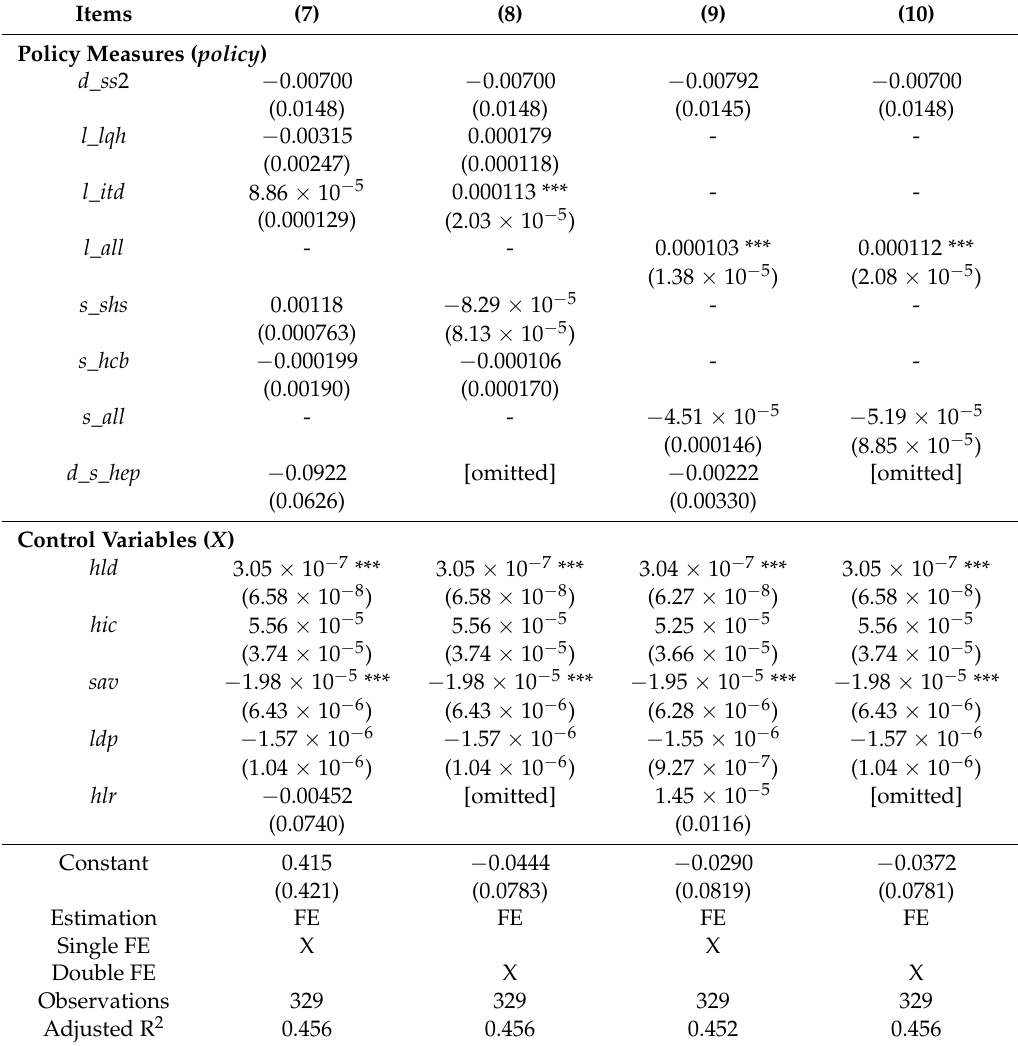
Table 6. Results of the panel data analyses for Case